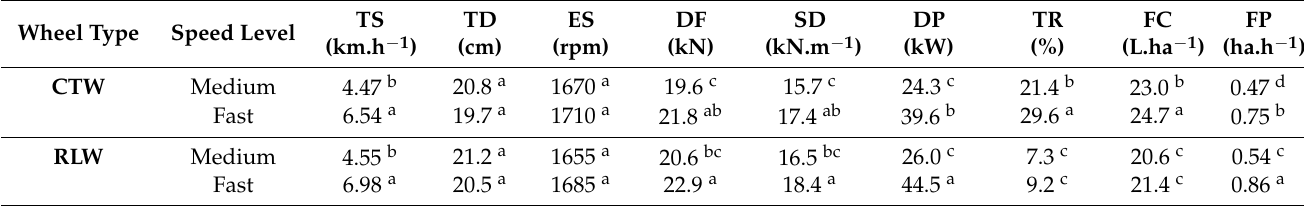
Table 5. Traction performance comparison of two wheels and the effect on fuel consumption and field productivity of the tractor for intensive tillage